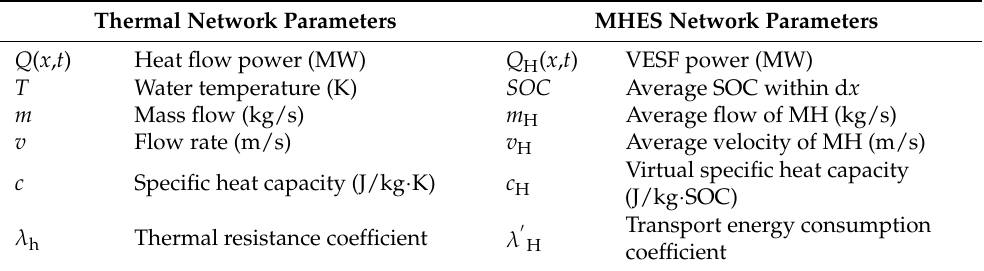
Table 1. Comparison of the thermal network and the MHES network.